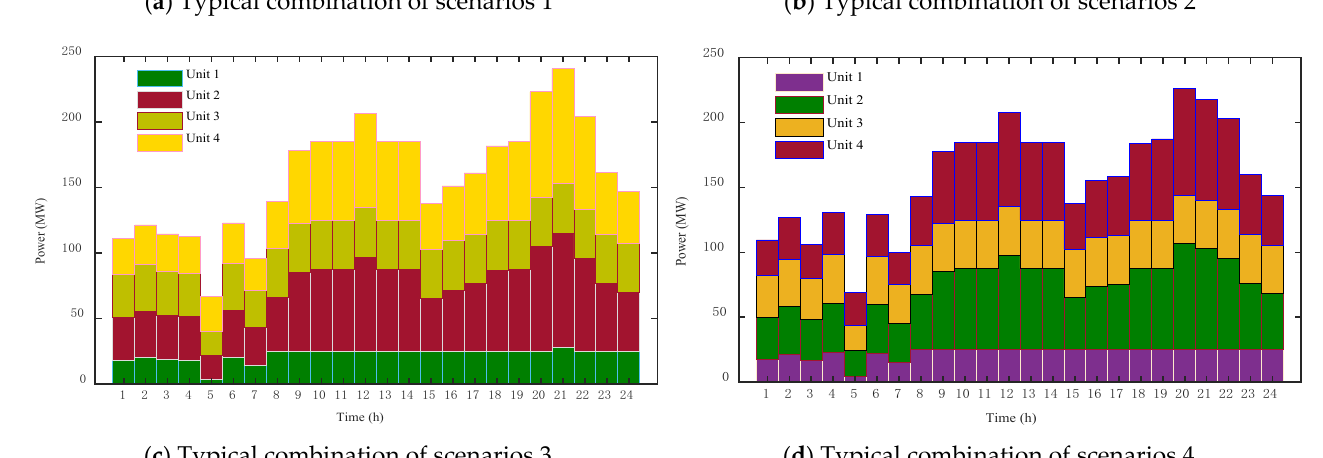
Figure 7. Optimal output of each thermal power unit under each typical combination of scenarios.